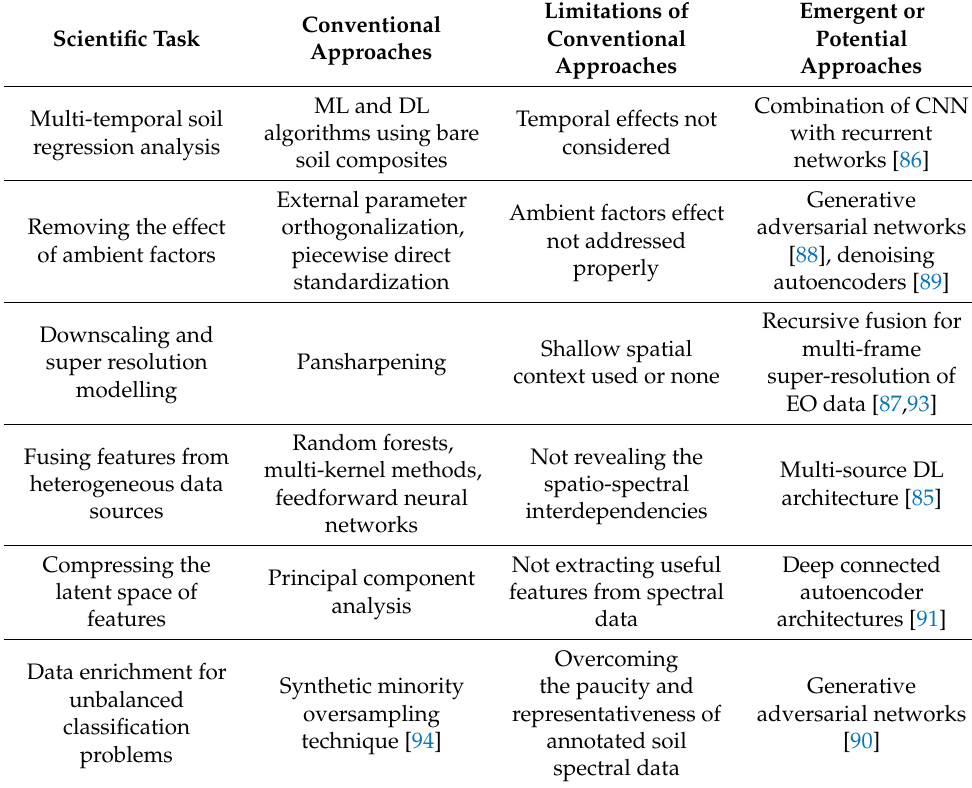
Table 2. Emergent and potential DL approaches in EO-based soil regression